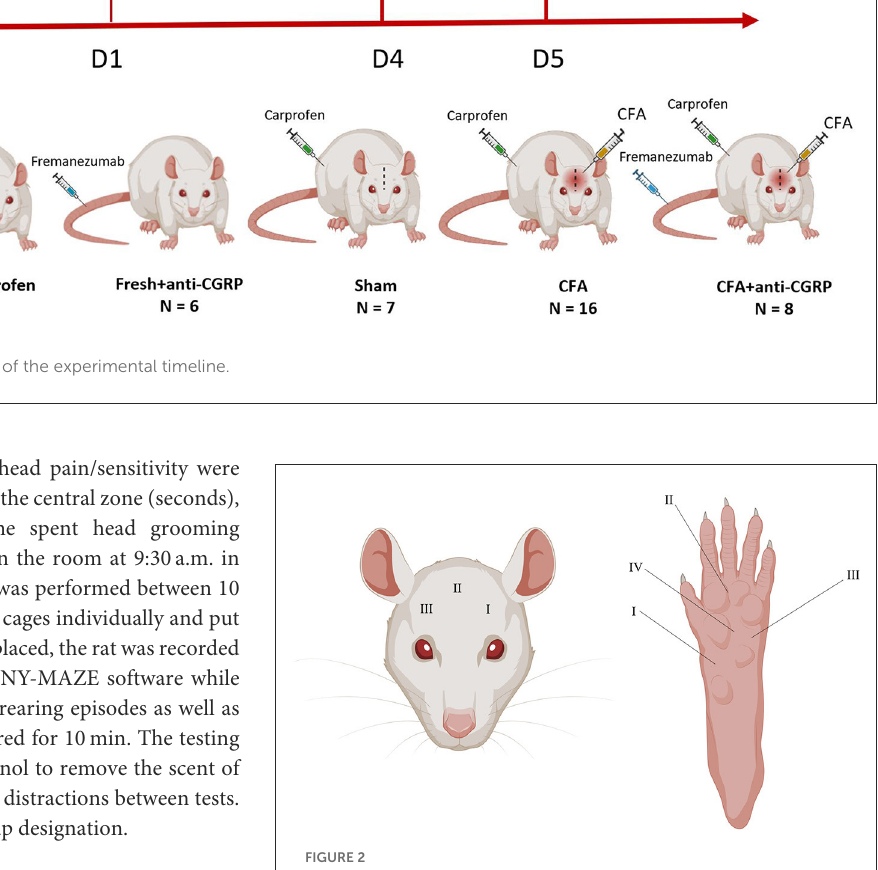
FIGURE2 Illustrative depiction of periorbital and plantar testing areas using the EVF. I–III on the ( Left) and I–IV on the ( Right) depicts where pressure was applied in chronological